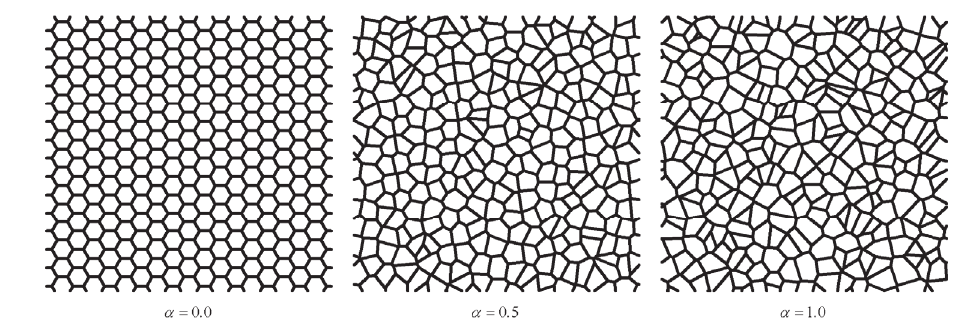
Figure 5: Effect of the irregularity parameter α : α = 0; α = 0.5; α =